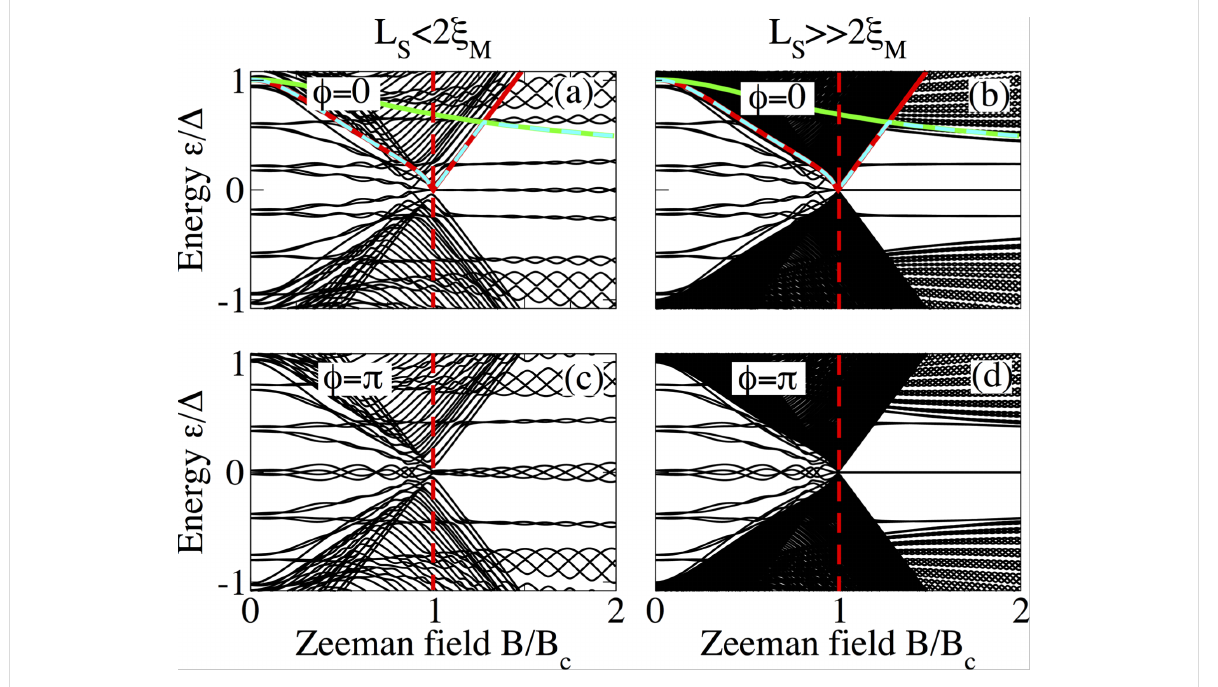
Figure 10: Same as in Figure 8 for a long junction with L N = 2000